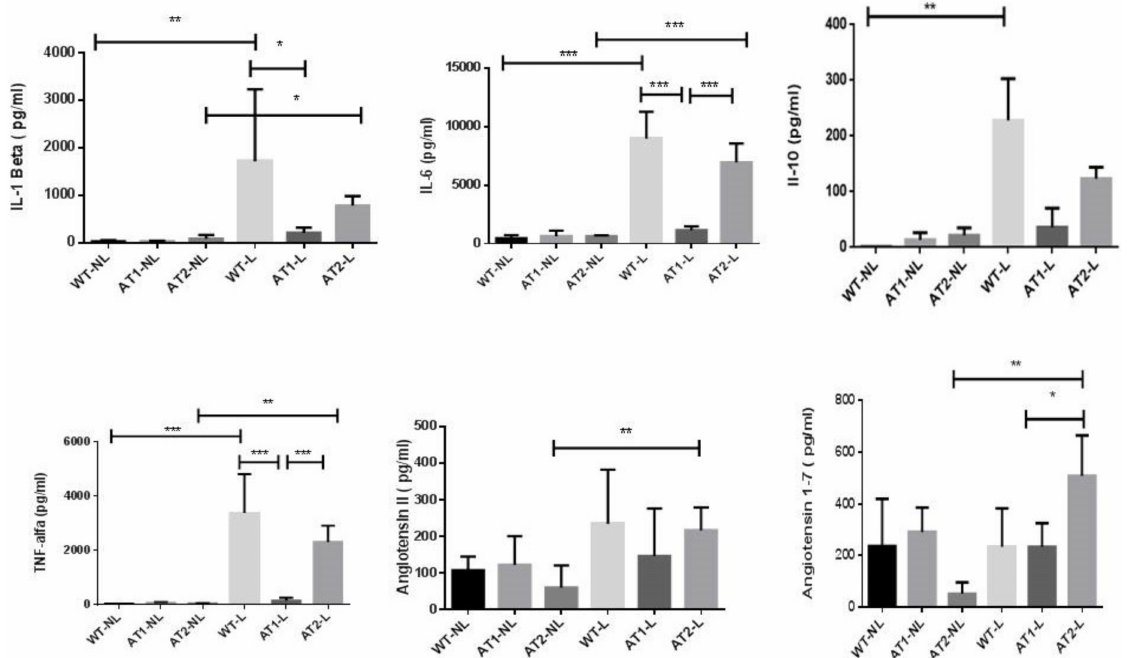
Figure 2. IL-1, IL-6, IL-10, TNF-, Ang 1-7 and Ang II levels for the no-ligature and ligature groups of the three knockout mouse strains by enzyme-linked immunosorbent assay (ELISA). Dosage of IL-1 levels; Dosage of IL-6 levels; Dosage of Il-10 levels; Dosage of TNF-levels; Dosage of Ang 1-7 levels; Dosage of Ang II levels. All graphs show mean and standard deviation ( n = 5/group). Statistical differences by brackets labeled by * p < 0.05, ** p < 0.01, *** p < 0.001, comparing WT-NL vs. WT-L, AT1-NL vs. AT1-L, AT2-NL vs. AT2-L, AT1-L vs. AT2-L, WT-L vs. AT1-L. (Graph Pad Prism 6.01